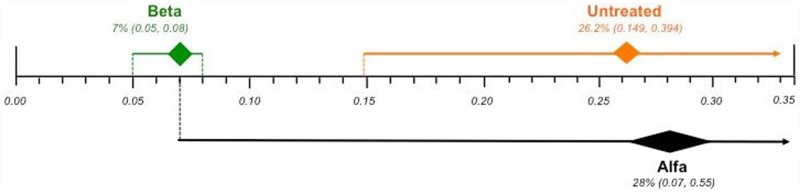
Comparison of the plotted proportional meta-analysis, according to ERT regimens, for cardiovascular complications.Effect differences were seen due to the non-overlap of the 95% confidence intervals favoring the use of agalsidase beta compared to untreated patients, as their CIs did not overlap. There was no statistically significance difference between agalsidase alfa and both untreated patients and agalsidase beta, as their CIs overlapped.